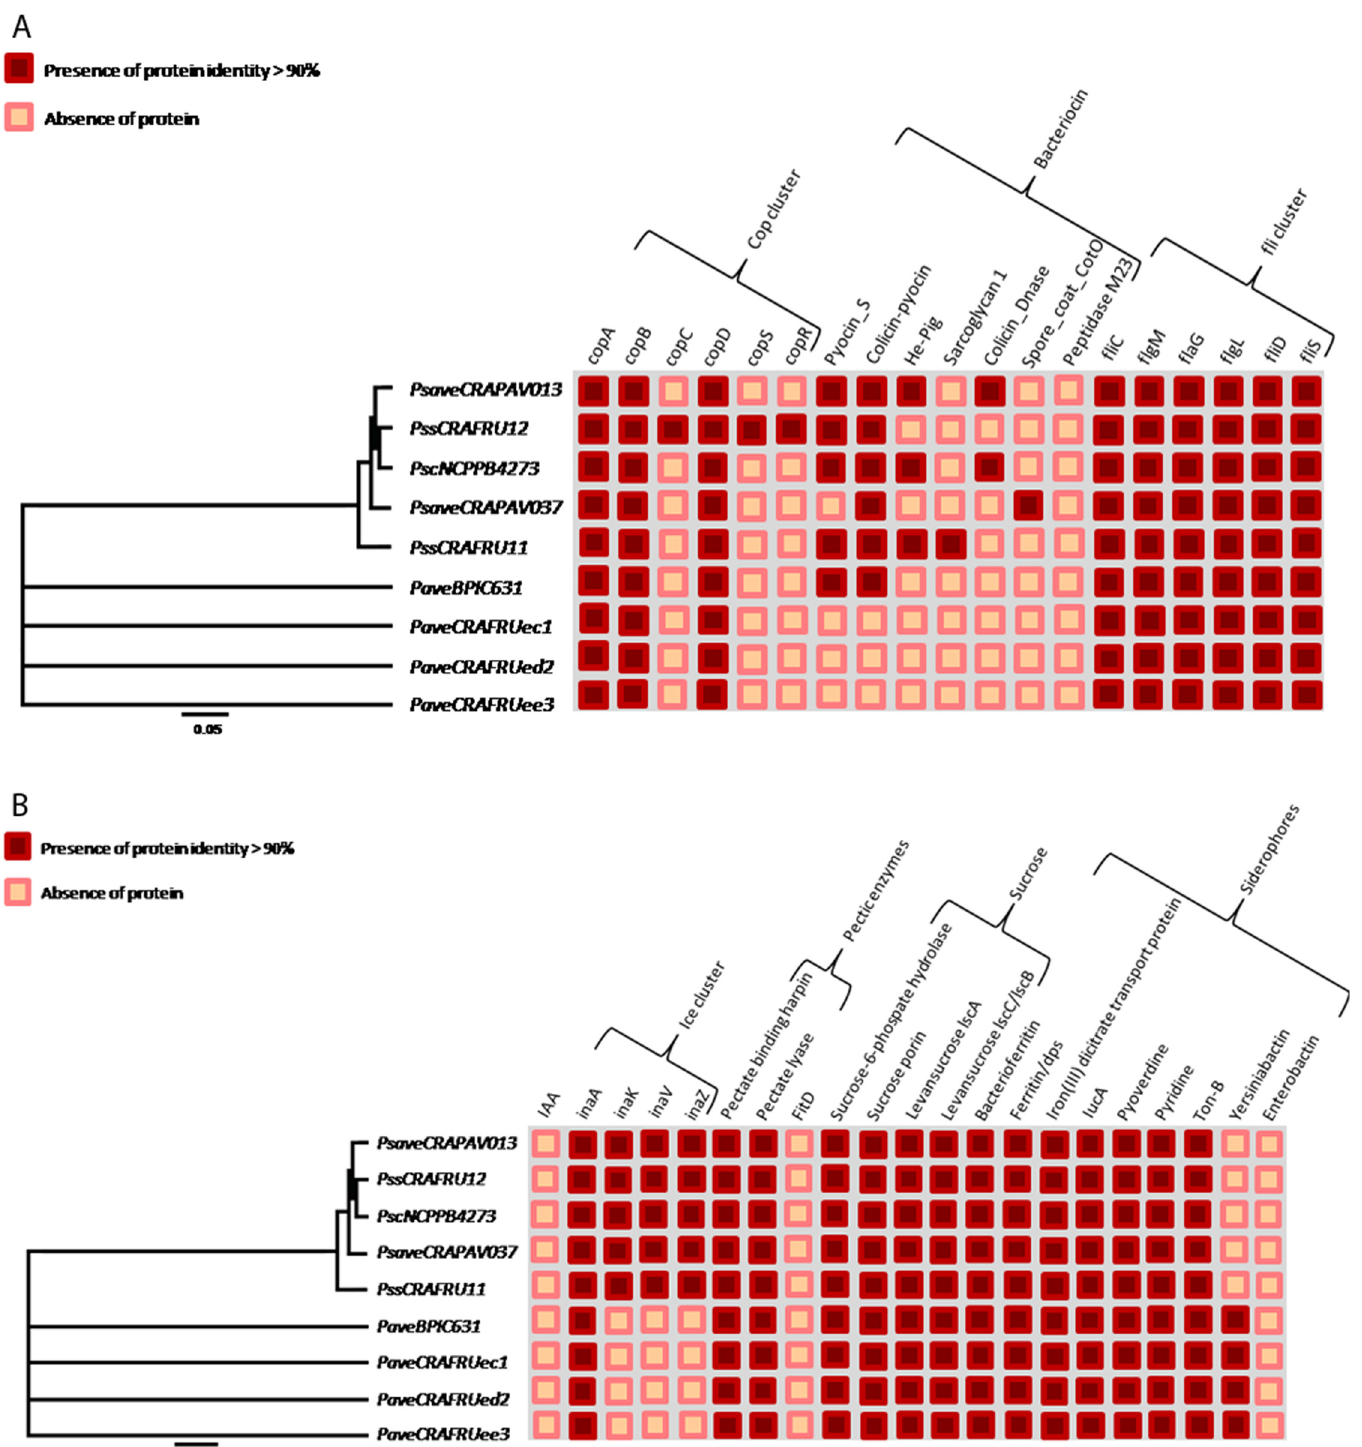
Fig 8. Presence/absence of putative homolog proteins in nine pseudomonad strains infecting Corylus avellana trees. The indication concerns the presence of copper resistance genes, bacteriocins, and the flagellin cluster (A), and ice nucleation activity, pectic enzymes, sucrose metabolism, and siderophores (B). Strain legend is shown in Table